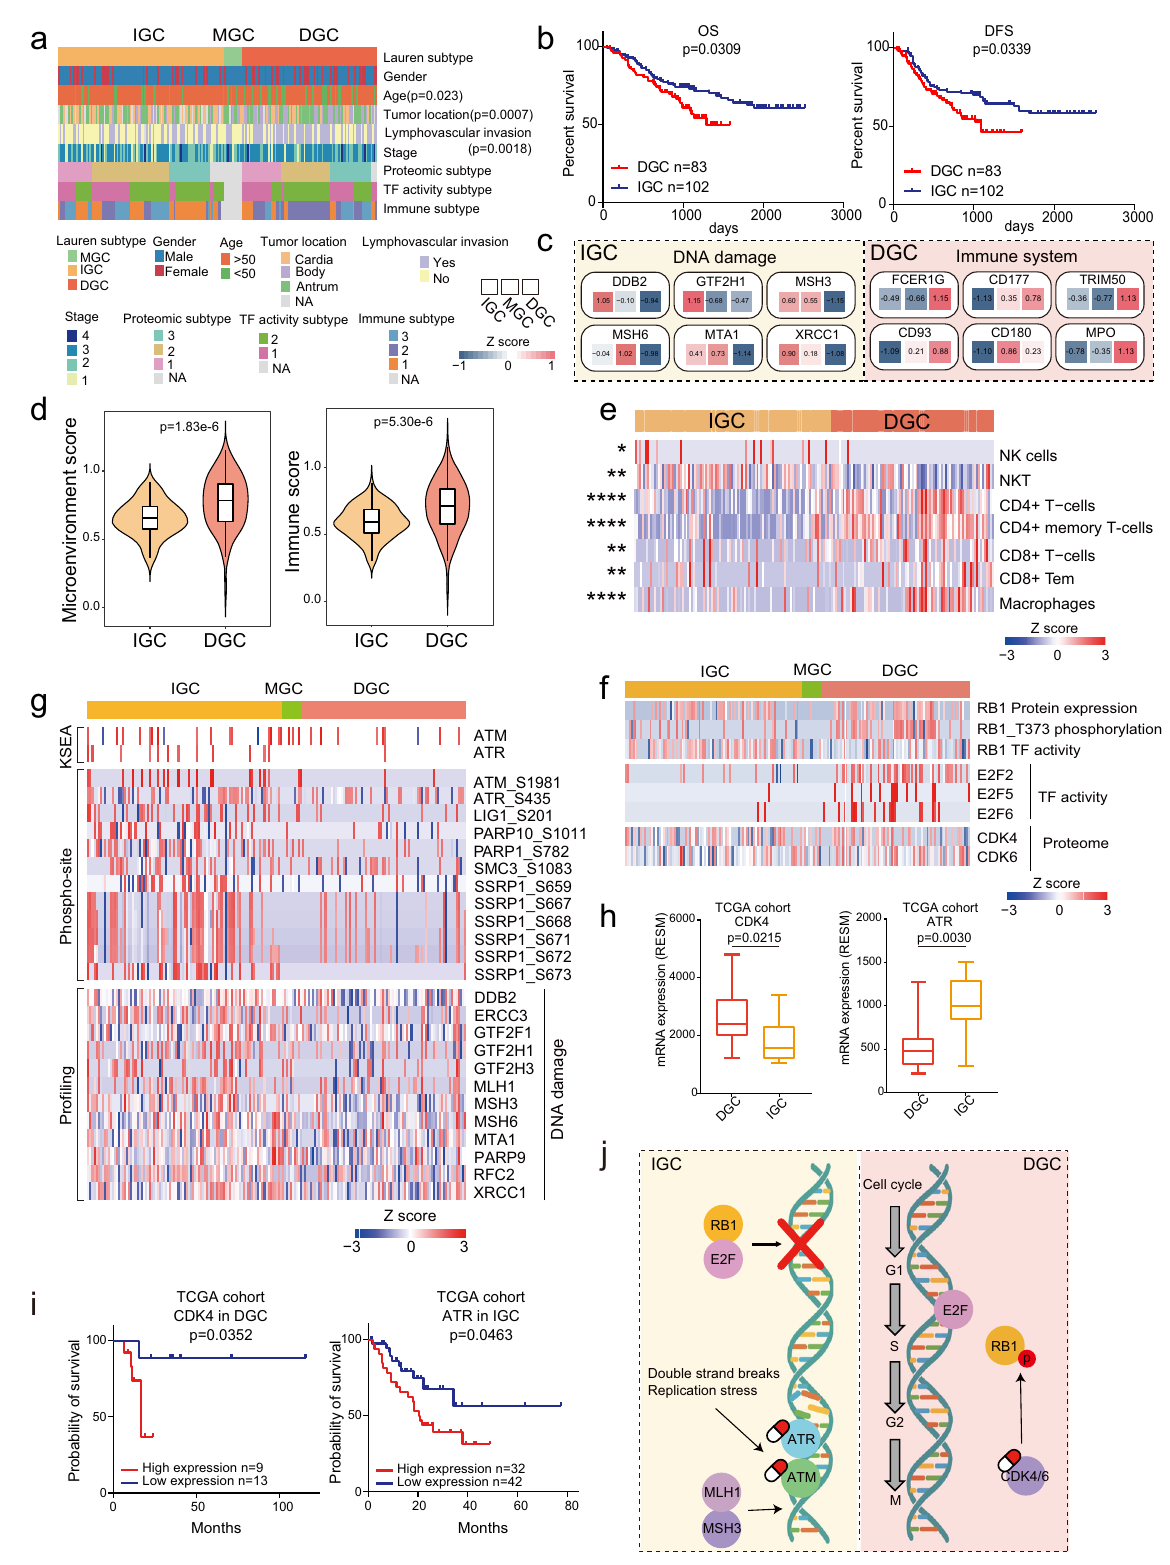
High expression n=32 Low expression